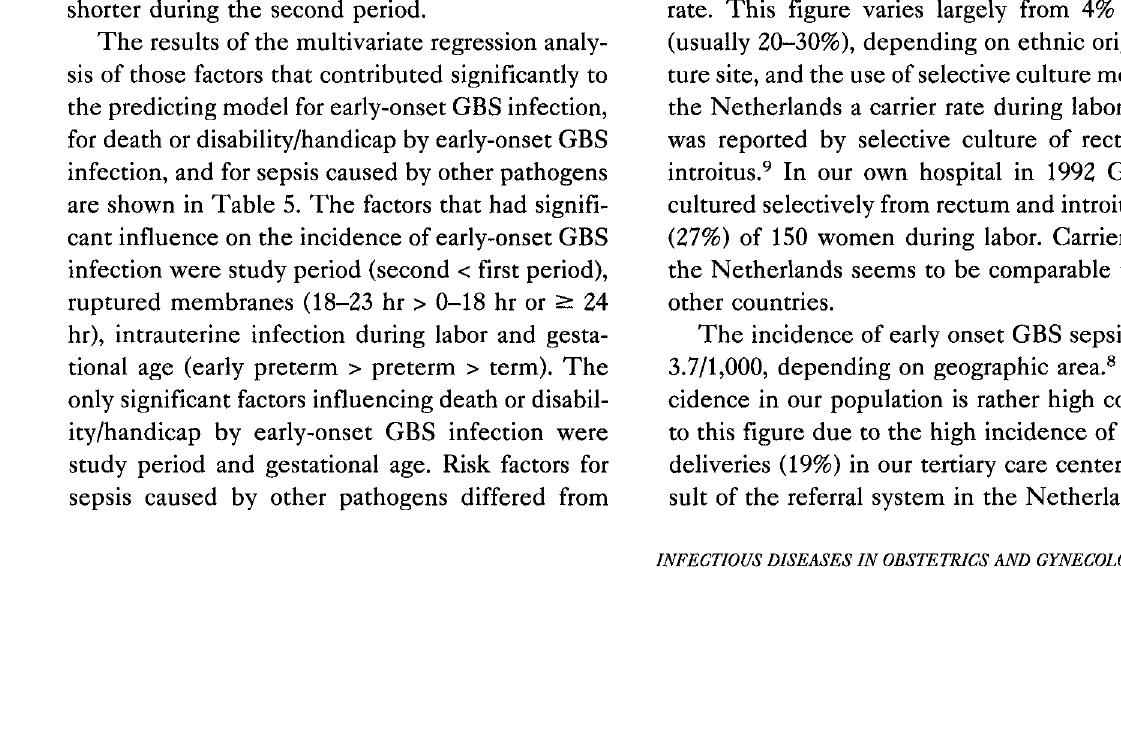
TABLE 4. Duration of neonatal intensive and high care for surviving infants according to gestational age, occurrence of early onset group B streptococcus (EOGBS) sepsis, sepsis by other pathogens, and